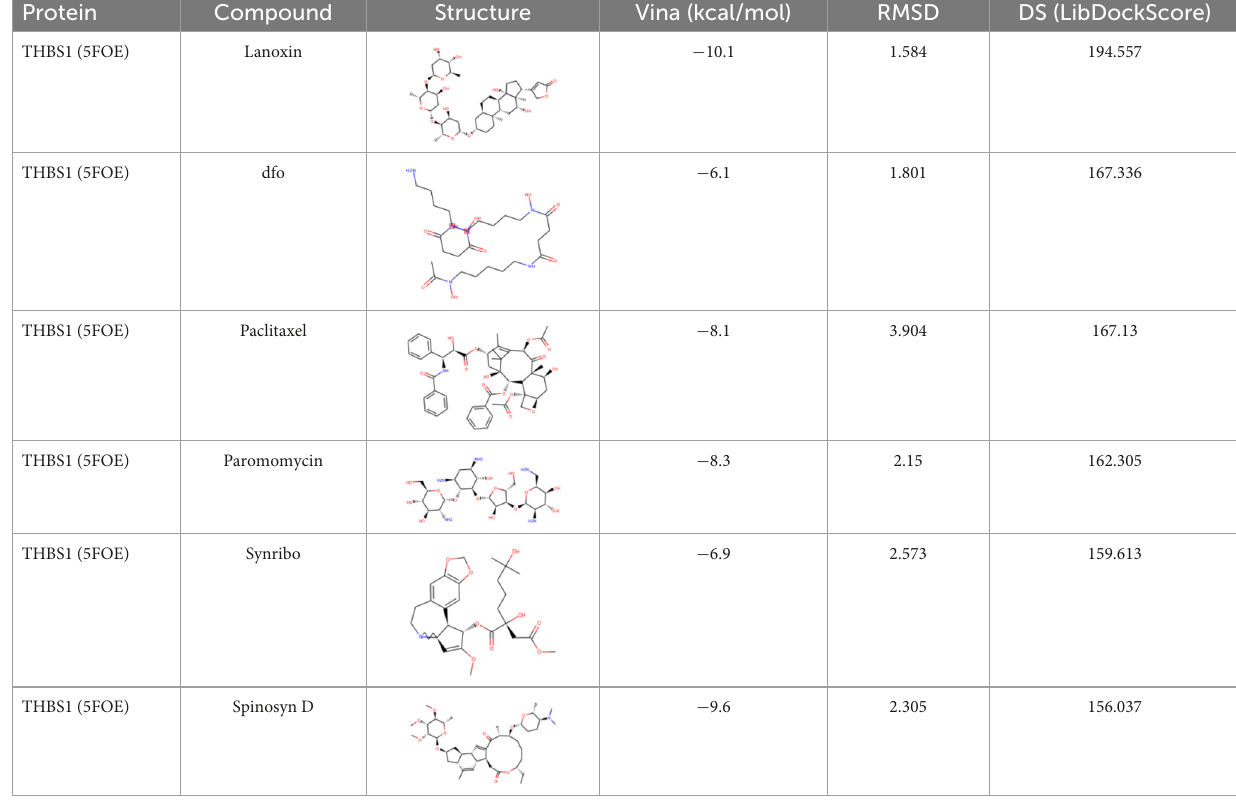
TABLE 2 Docking of THBS1 with the first six Food and Drug Administration (FDA)-approved drugs. Protein Compound